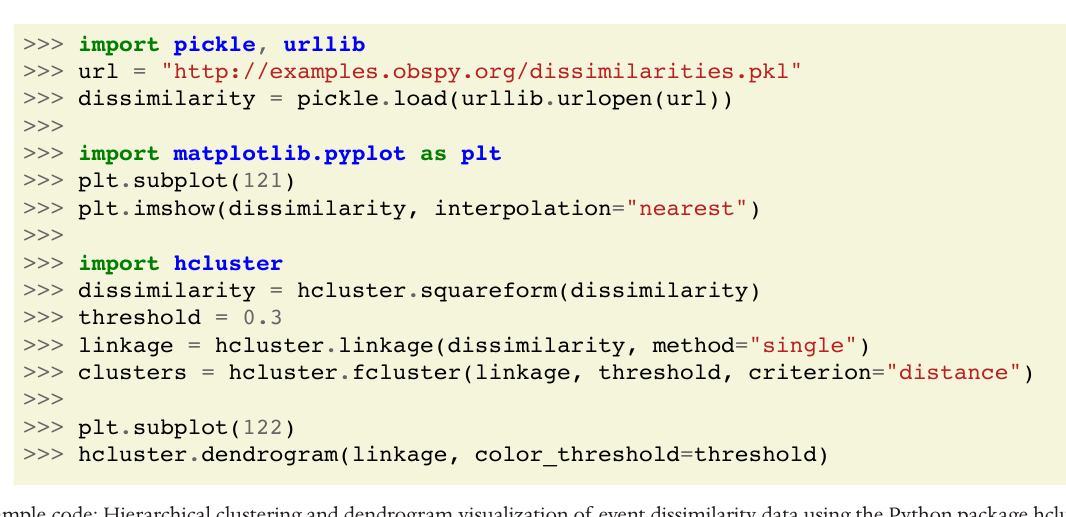
Figure 2. Example code: Hierarchical clustering and dendrogram visualization of event dissimilarity data using the Python package hcluster.